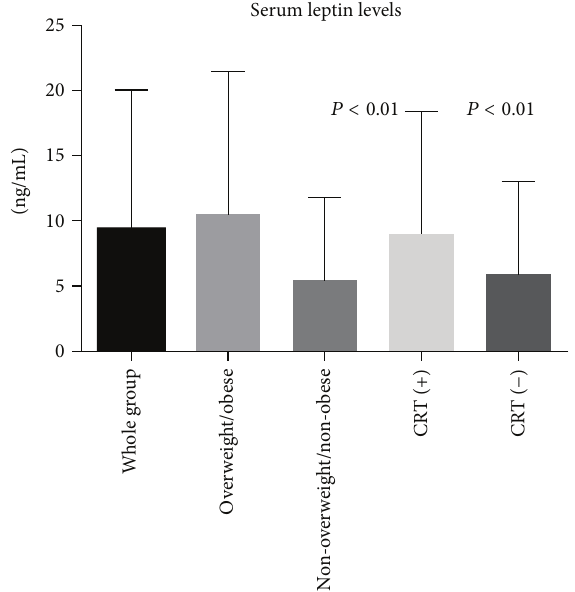
Figure 1: Serum leptin levels in the whole group, overweight/obese and nonoverweight/obese subjects ( 𝑃 < 0.01 ), and patients who receive and who did not received cranial radiotherapy ( 𝑃 < 0.01 ).